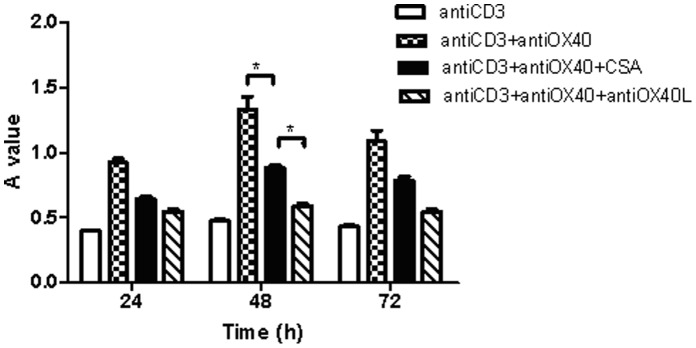
The proliferation of lymphocytes after interfered OX40-OX40L interaction.*p<0.05 compared to control.